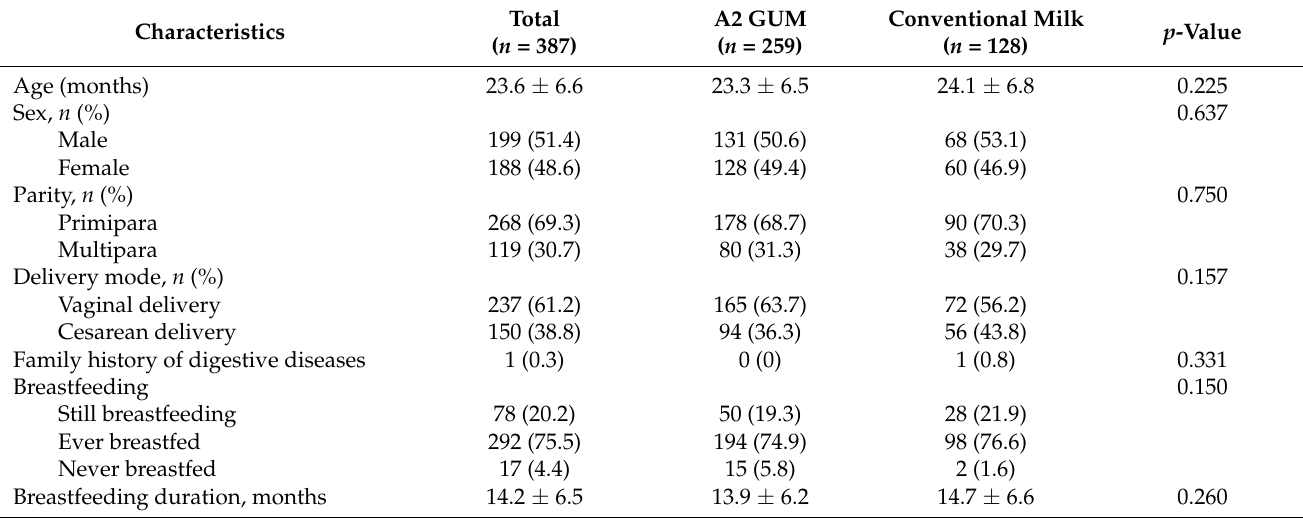
Figure 1. Flow chart. Table 1. Demographic and anthropometric characteristics of toddlers at